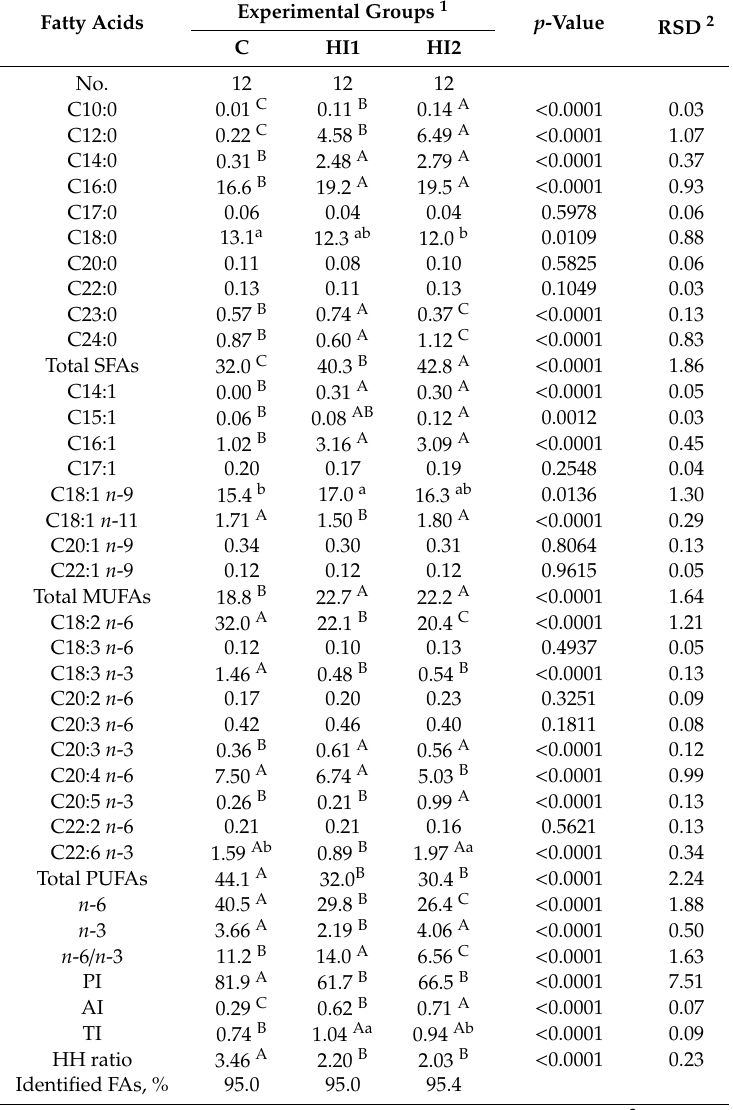
Table 5. E ff ect of the dietary inclusion of Hermetia illucens dried larvae farmed on di ff erent growth substrates (HI1, HI2) on the fatty acid profile (% of total FAMEs) of broiler quail breast meat. Experimental Groups Fatty Acids